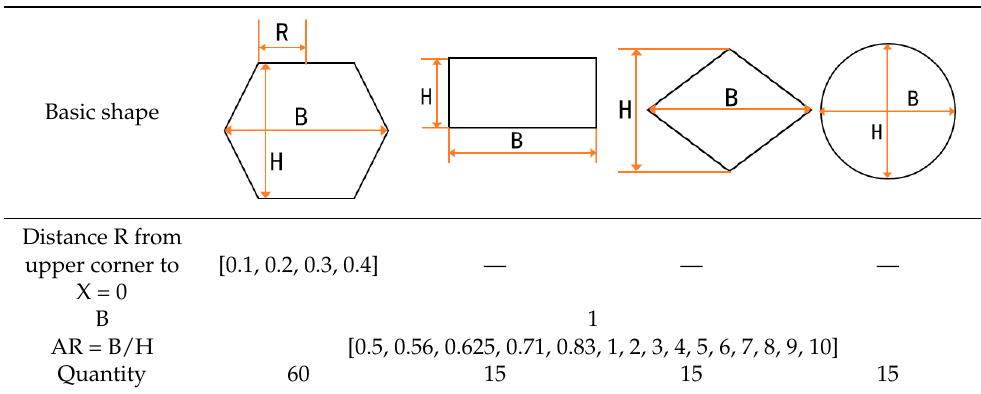
Table 1. List of the shape conditions.